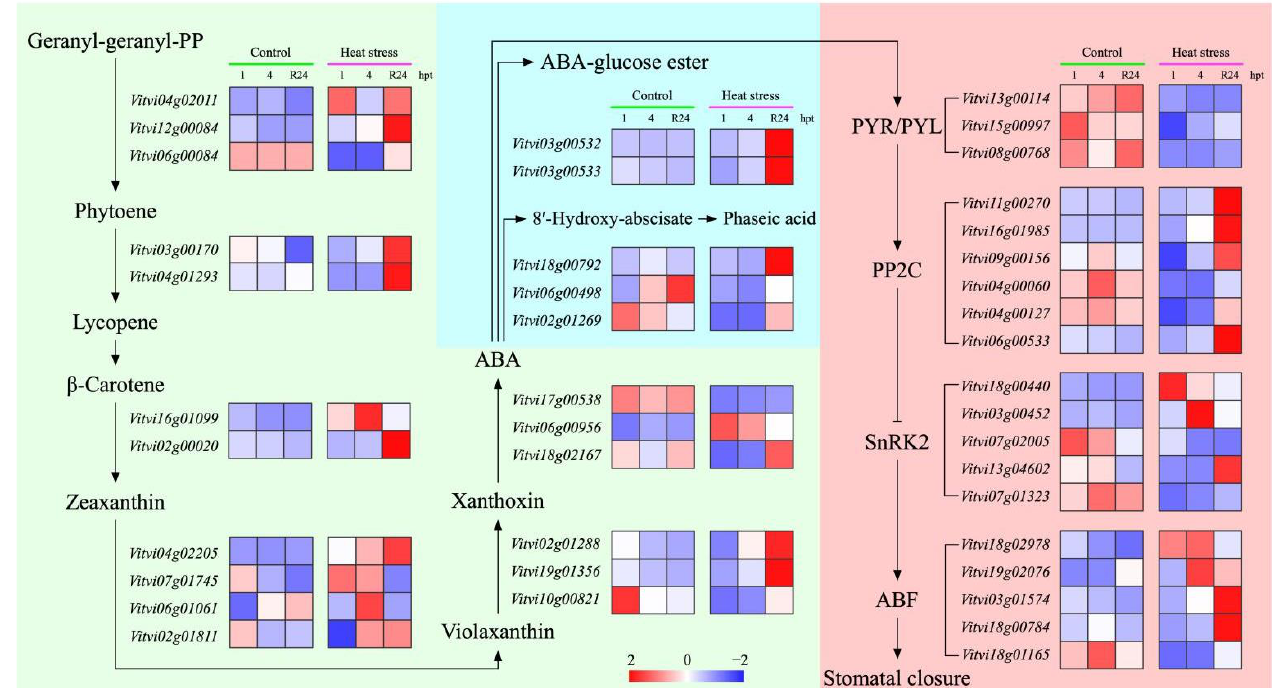
Figure 6. Transcriptomic profiles of DEGs involved in the ABA biosynthesis, metabolism, and signal transduction pathways following HS treatment and subsequent recovery. Different shades of red and blue express the average FPKM value (log2 transformed) of the gene in each sample, as illustrated in the